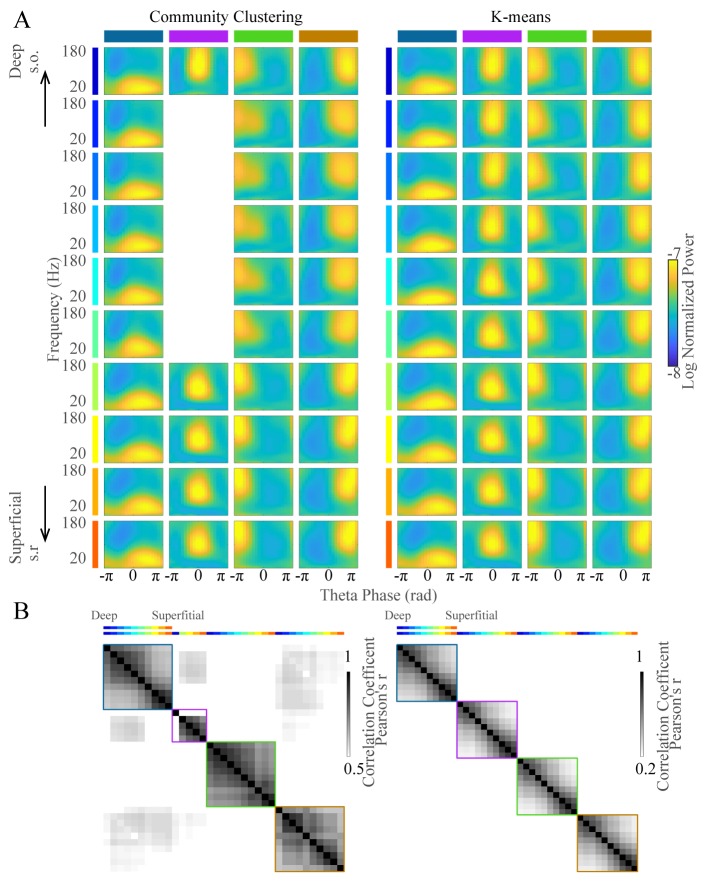
Clustering of wavelet power in frequency and theta phase domains.(A) Average LFP power across frequency and phase for each cluster (columns) for all recording sites from deep to superficial channels (top to bottom) from the same shank of one probe. These data include all awake theta periods from one animal. (B) Correlation over time of the occurrence rate of each TG state between channels. The first row indicates the correlation overtime for theta cycles classified as in TG state one on the first channel correlated with the classification on all other channels. s.o., stratum oriens; s.r., stratum radiatum.